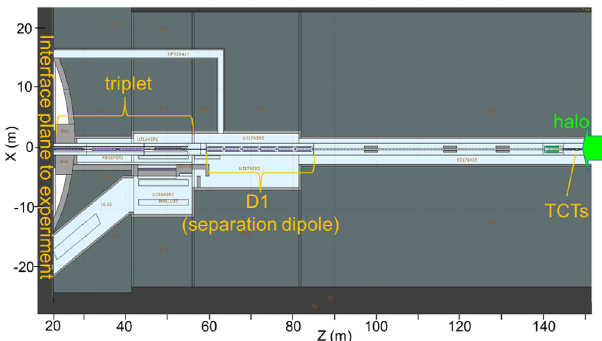
FIG. 9. Top view of the IR1 geometry implemented in F LUKA . The TCTs, which are intercepting the halo, are located at the right edge at about 145 m from the IP. The induced shower is simulated up to a virtual interface plane to the experiment, at the left edge of the figure at 22.6 m from the IP.